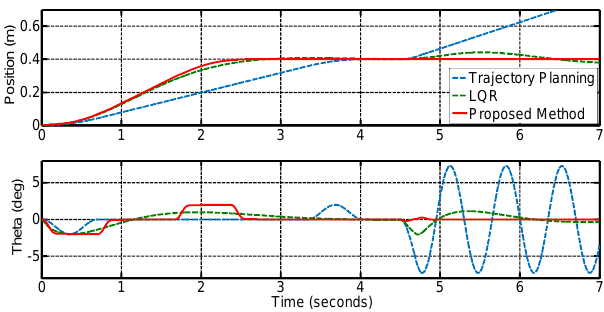
Figure 9. Response of different controllers with external disturbances.